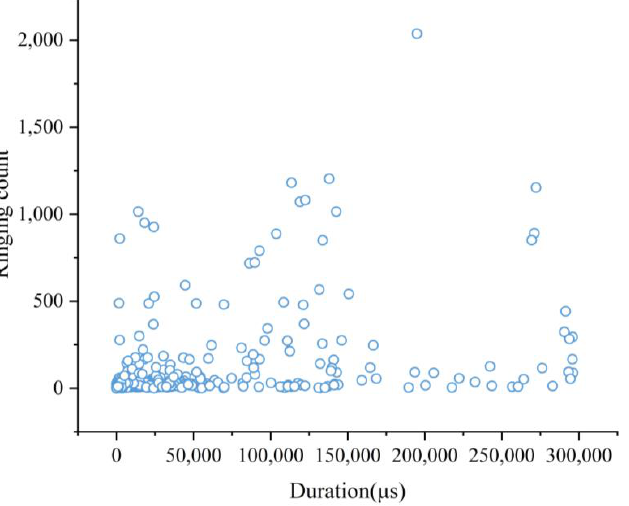
Figure 12. Ring count-duration correlation diagram of cable noise signal of Yellow River Bridge.